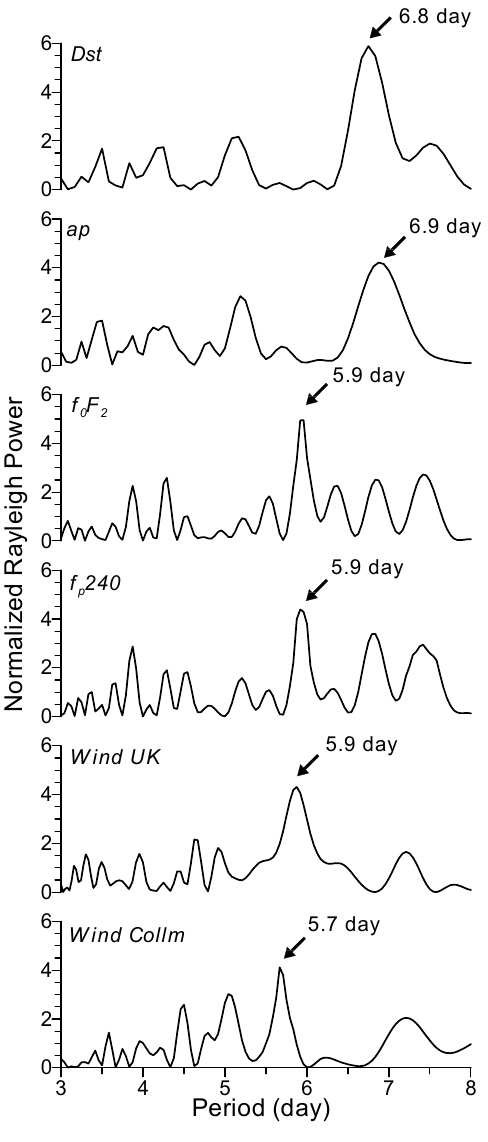
Fig. 4. Normalized Rayleigh power computed for the indicated time series in the time interval from 1 June to 31 August 1998. Arrows indicate the dominant period of oscillation of each time